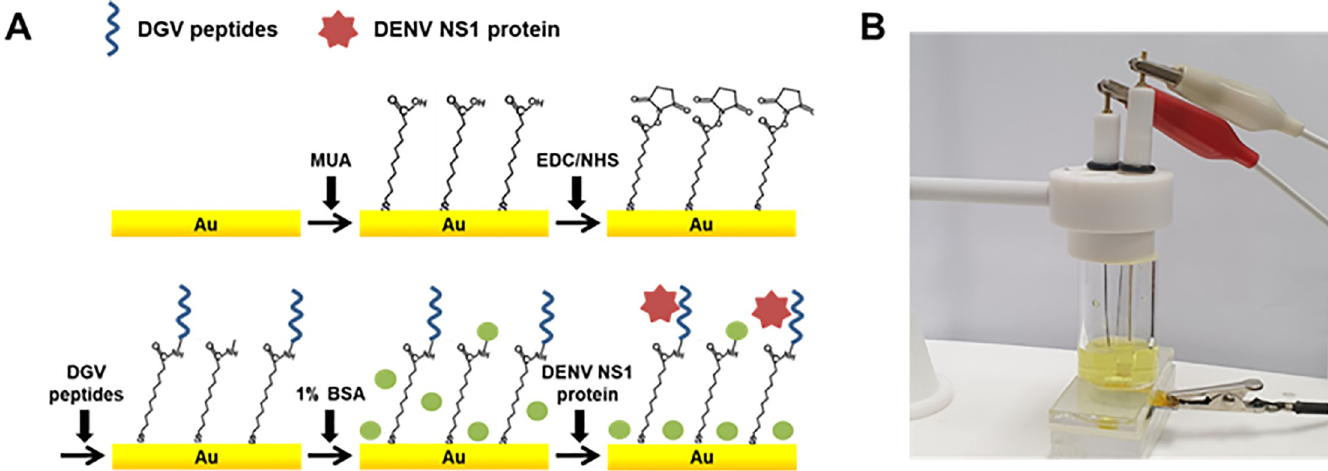
Fig 1. Schematic illustration of the peptide-decorated electrochemical sensor for the detection of dengue fever biomarker, NS1. The functionalized gold surface was exposed to a solution of synthetic peptides to create the affinity peptide-decorated electrochemical sensor for the detection of the dengue virus antigen, nonstructural 1